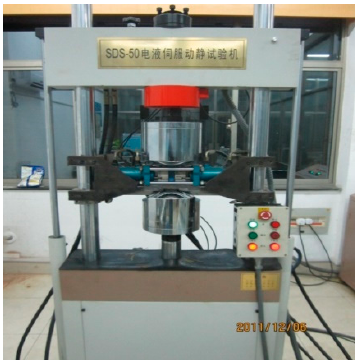
Figure 6. Picture of the fretting fatigue experimental setup.